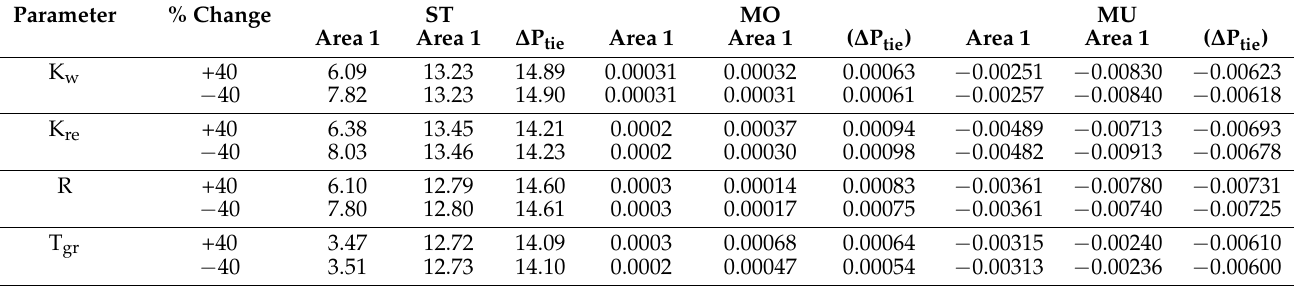
Figure 12. Sensitivity analysis for the system parameters.